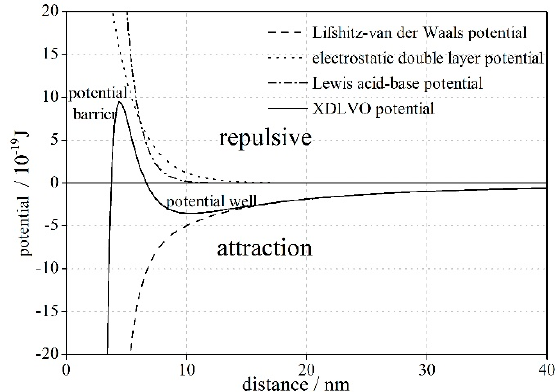
Figure 2. The XDLVO potentials of different net distances h ij between particles. The Lifshitz ‒ van der Waals potential is always attractive; the electrostatic double-layer potential is repulsive and the Lewis acid ‒ base potential’s sign depends on the properties of colloids. XDLVO potential is the summation of the aforementioned three potentials, resulting in potential wells and potential barriers. Particles whose interactive forces conquer the potential barrier can form a stable floc.